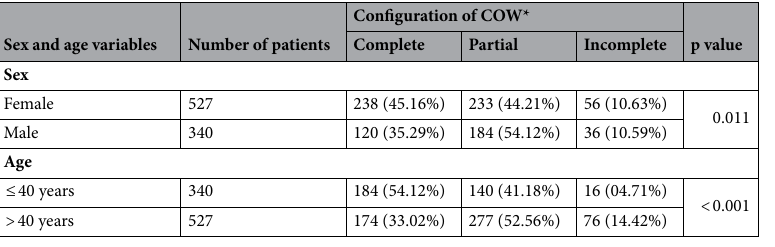
Table 7. Sex and gender distribution according to configuration of the COW * . *Circle of